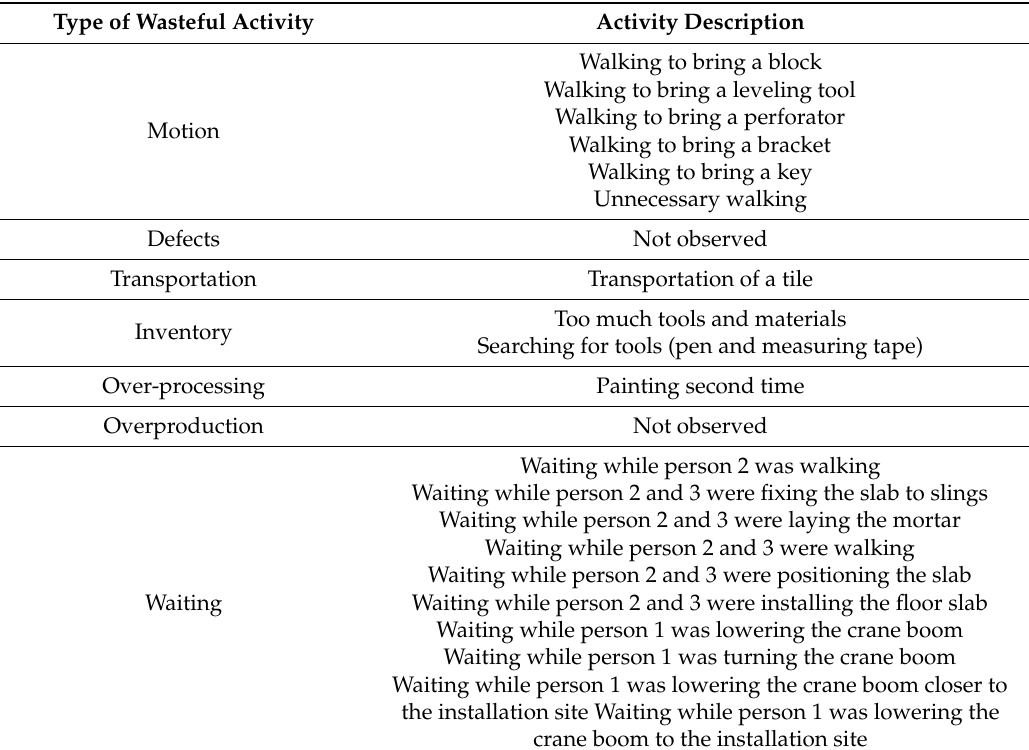
Table 5. Type of wasteful activities in the construction processes as identified from observations.